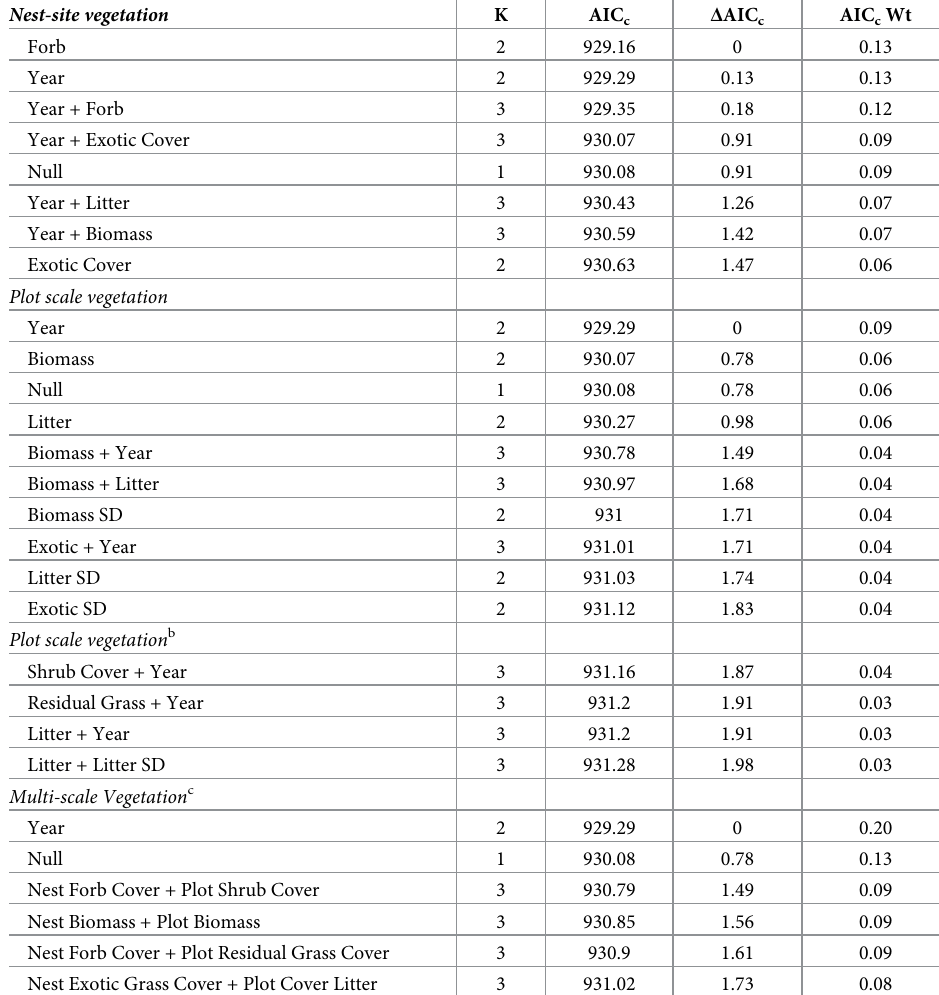
Table 2. Model selection table for daily survival rate of 263 chestnut-collared longspur nests in 100 9-ha plots in Phillips County, MT, during May–July of 2017 and 2018. Nest-site